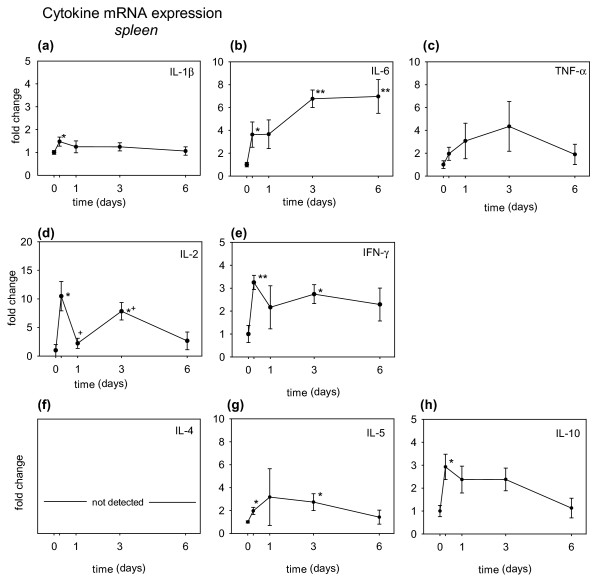
Expression of mRNA for various cytokines in the spleens of rats with AIA. Time course and details as in Fig. 2. AIA, antigen-induced arthritis.